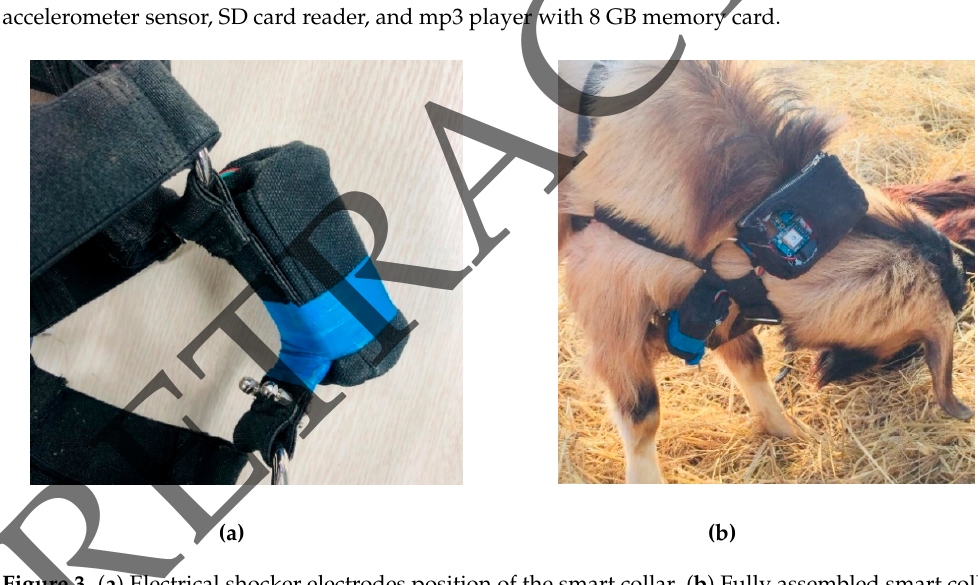
Figure 3. (a) Electrical shocker electrodes position of the smart collar. (b) Fully assembled smart collar worn on the goat.